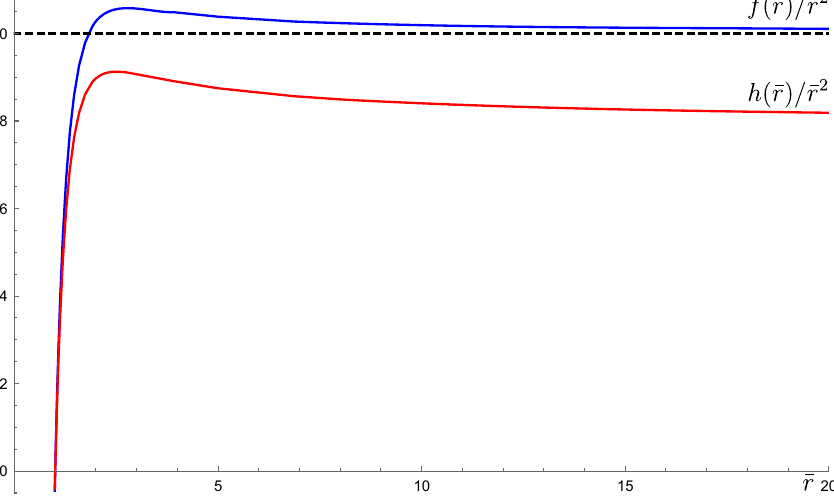
not necessary to obtain an asymptotically AdS spacetime (see Sect. 5 for further comments). This observation for the quadratic-gravity black holes is in agreement with previous numerical results of [25] obtained in the case of Einstein–Weyl gravity. In contrast, in the (cid:2) = 0